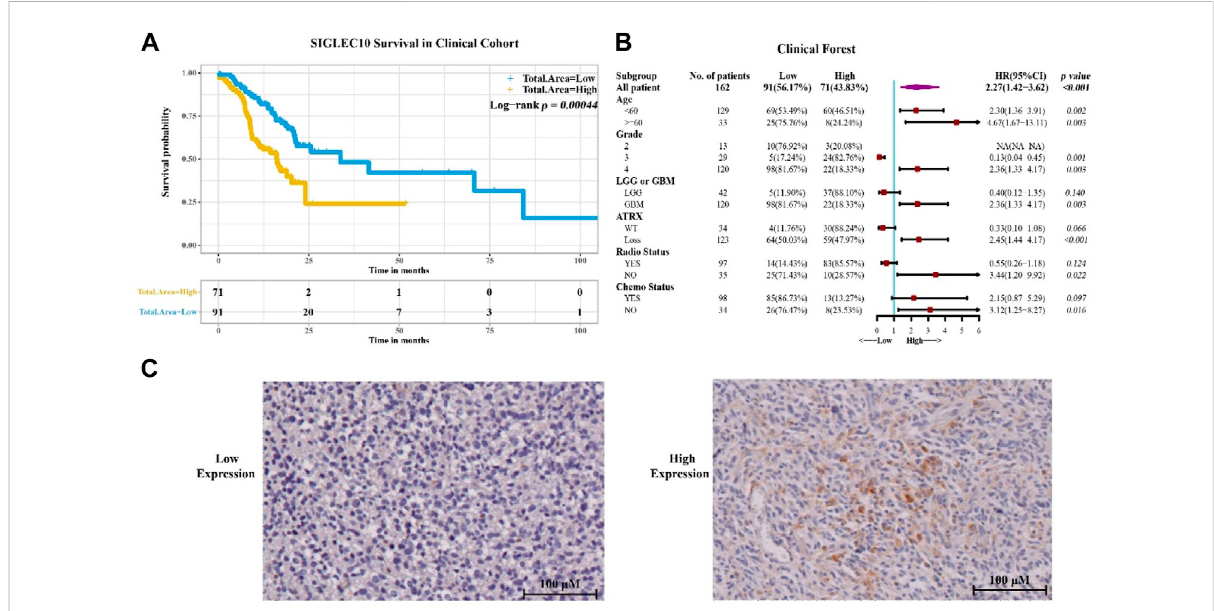
FIGURE 2 Siglec10 expression in glioma patients. (A) Siglec10 survival in the clinical cohort with the immunohistochemical staining method. High siglec10 expression patients had shorter survival prognosis than low siglec10 expression patients ( p ＜ 0.001). (B) Clinical forest of the cohort. High siglec10 expressionhadshortersurvivalprognosis thanlowsiglec10expressioninpatientswithgrade4( p =0.003),GBM( p =0.003),ATRXloss( p ＜ 0.001), no radiotherapy ( p = 0.022), or no chemotherapy ( p = 0.016). (C) Immunohistochemical staining of SIGLEC10